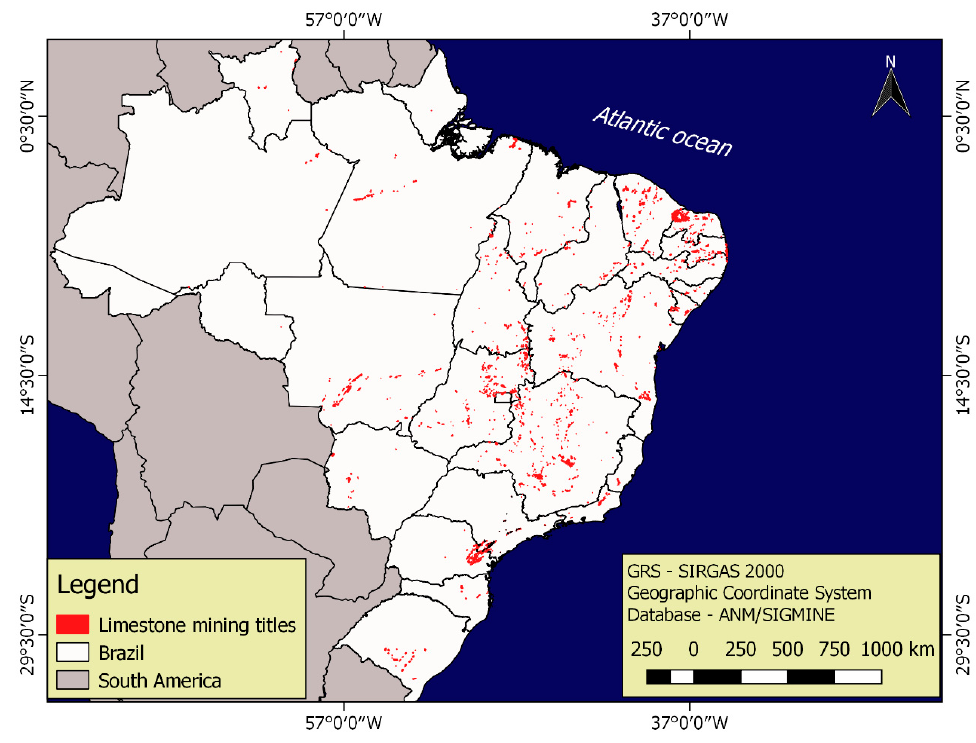
Figure 3. Distribution of limestone mining titles throughout the Brazilian territory, covering an area of 27,129 km².